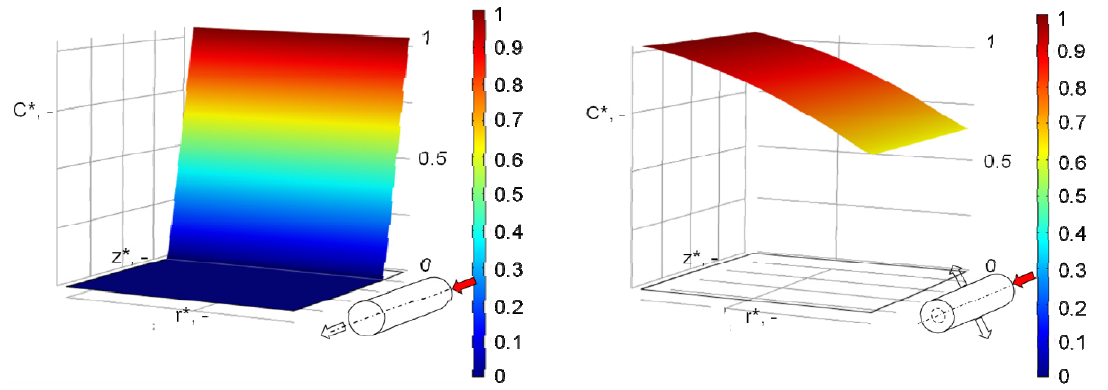
Figure 4. Dimensionless oxygen concentrations in a 3D porous bone construct perfused with medium: ( a ) axially (Pe γ = 1). Parameter values: C parameters are as in Tables 2 and